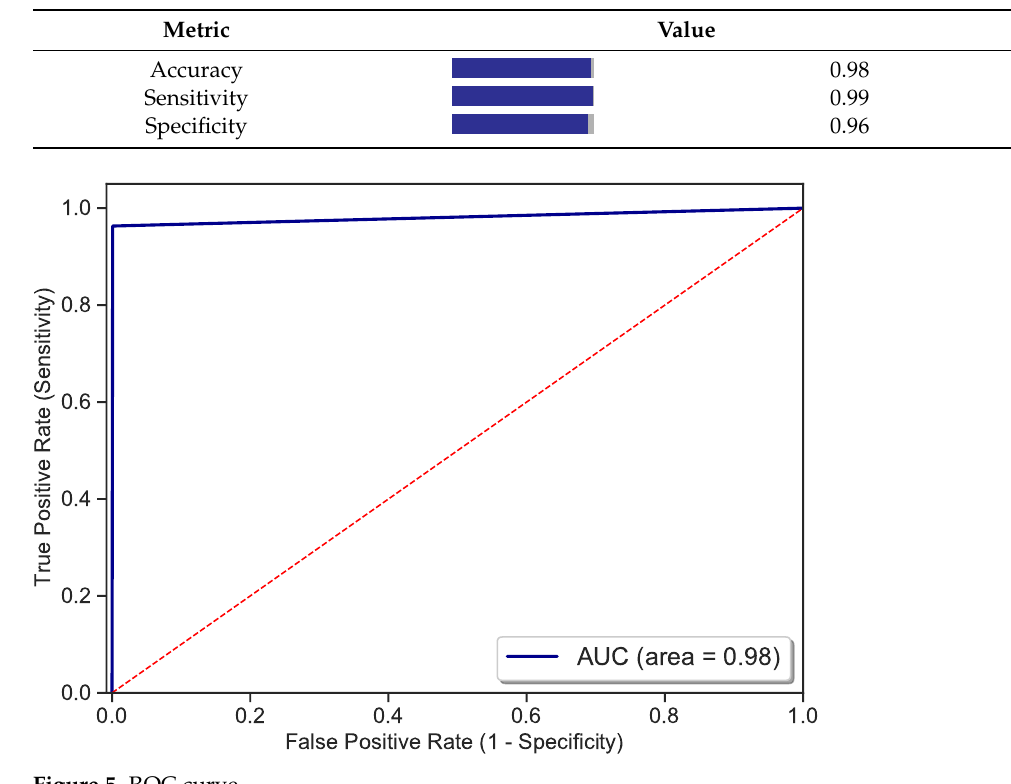
Table 3. Key metrics of the optimized LightGBM model.